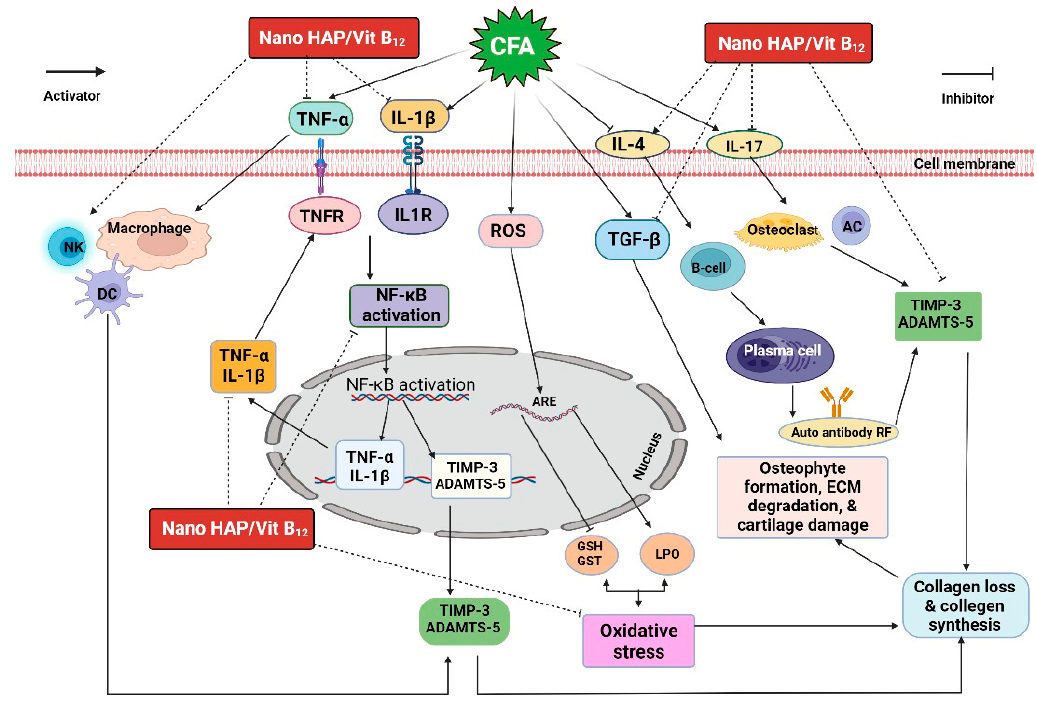
Figure 11. Schematic figure illustrating mechanisms of actions of nano-HAP/Vit B 12 in arthritic rats.